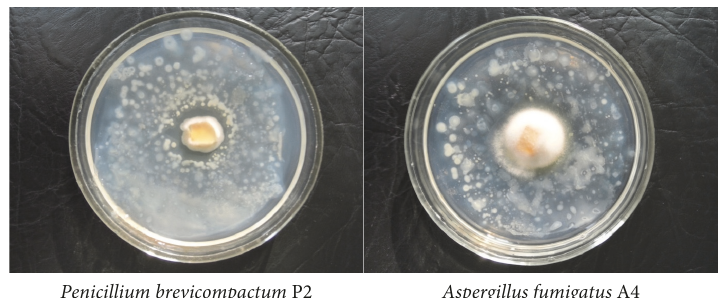
Figure 4: Antagonistic activity of micromycetes towards the bacterial community. The transparent zone around the agar block appearing after 2 days of incubation at 28 ∘ C reflects the inhibition of bacterial growth by secreted secondary metabolites of